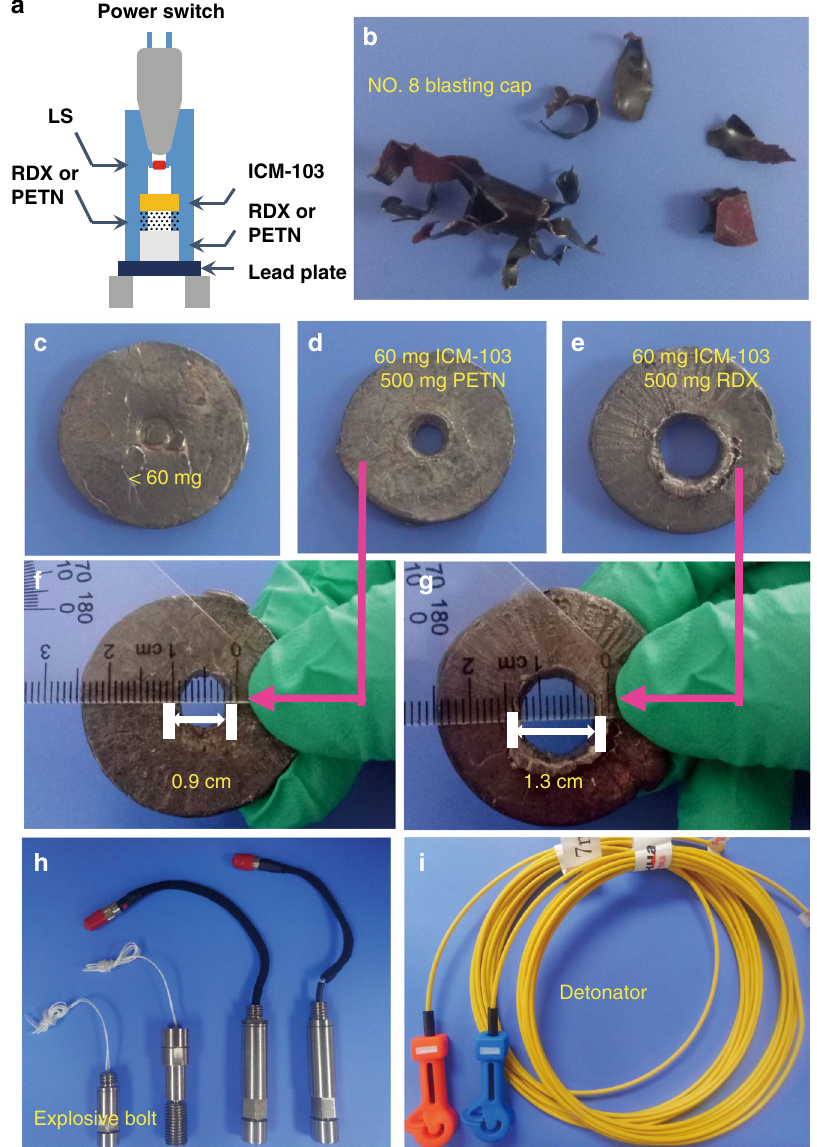
Fig. 4 Initiation capability test of ICM-103. a Initiation capability test apparatus. b Fragmentation of the cap caused by a de fl agration-to-detonation transition (DDT) of PETN or RDX. c One of the lead plates that cannot be blasted out of the hole by using <60 mg ICM-103 sample. d – g Lead plates that were blasted out of the hole by using 60 mg ICM-103 sample, with PETN and RDX as main charge, respectively. h , i Two important products charged with 60 – 80 mg ICM-103